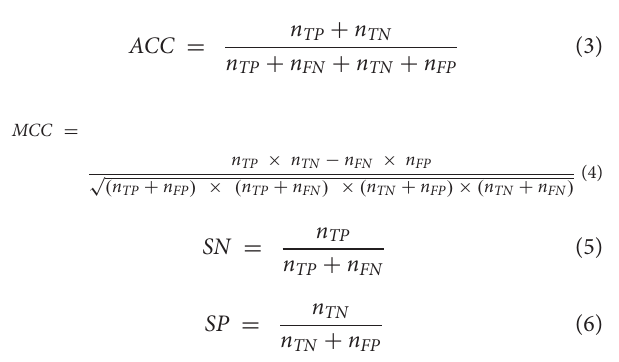
Table 1 , the columns represent 15 physicochemical properties, and the rows represent 25 dinucleotides. In Supplementary Table 2 , the columns represent 11 physicochemical properties, and the rows represent 125